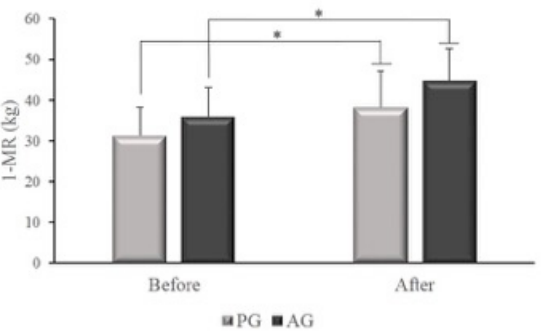
Figure 2 - Values as means and standard deviations of 1-MR